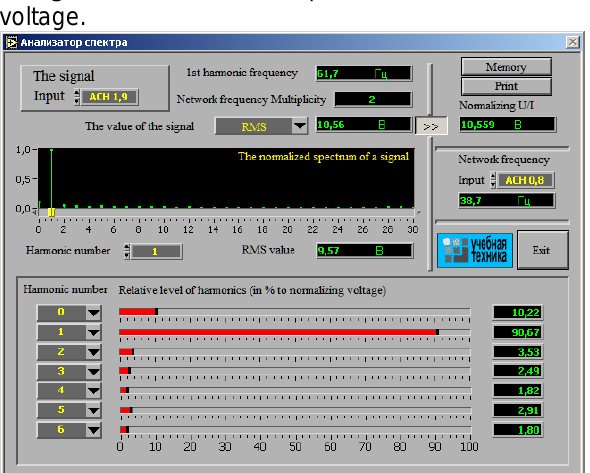
Figure 8. Harmonic composition of the stator voltage.